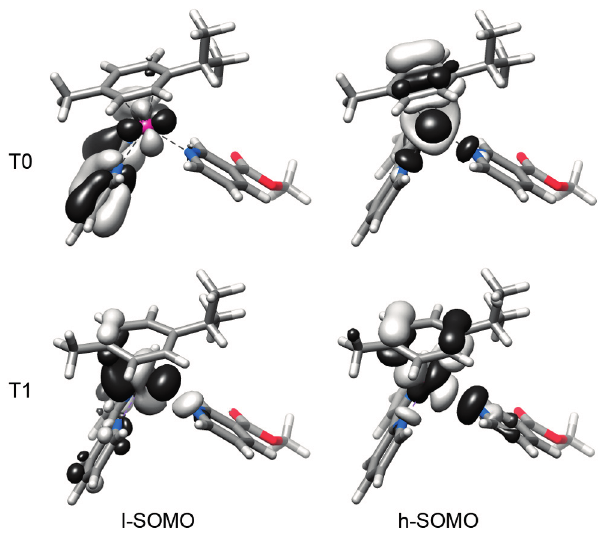
Figure 4. Calculated lowest- and highest-Single Occupied Molecular Orbitals (h-SOMO and l-SOMO), for complex 3 in the T0 and T1 optimized geometries.